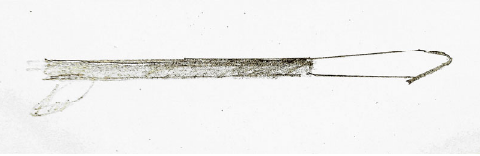
Figure 11. Self ‐ made stainless steel minimally invasive nail extractor.